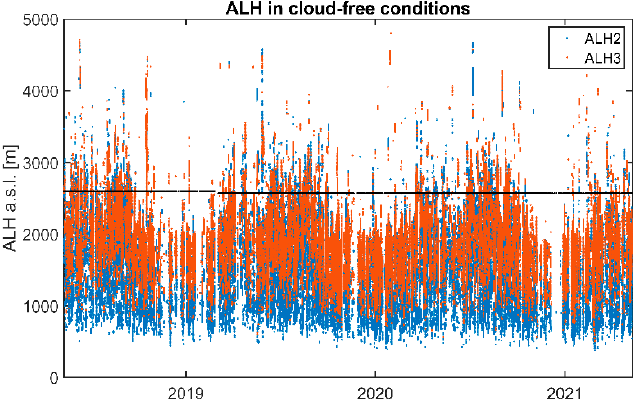
Figure 9. Number of ALH2 and ALH3 in cloud-free conditions over the entire three-year period. The black horizontal line shows an altitude of 2500 m a.g.l., which is the lower limit for our algo-